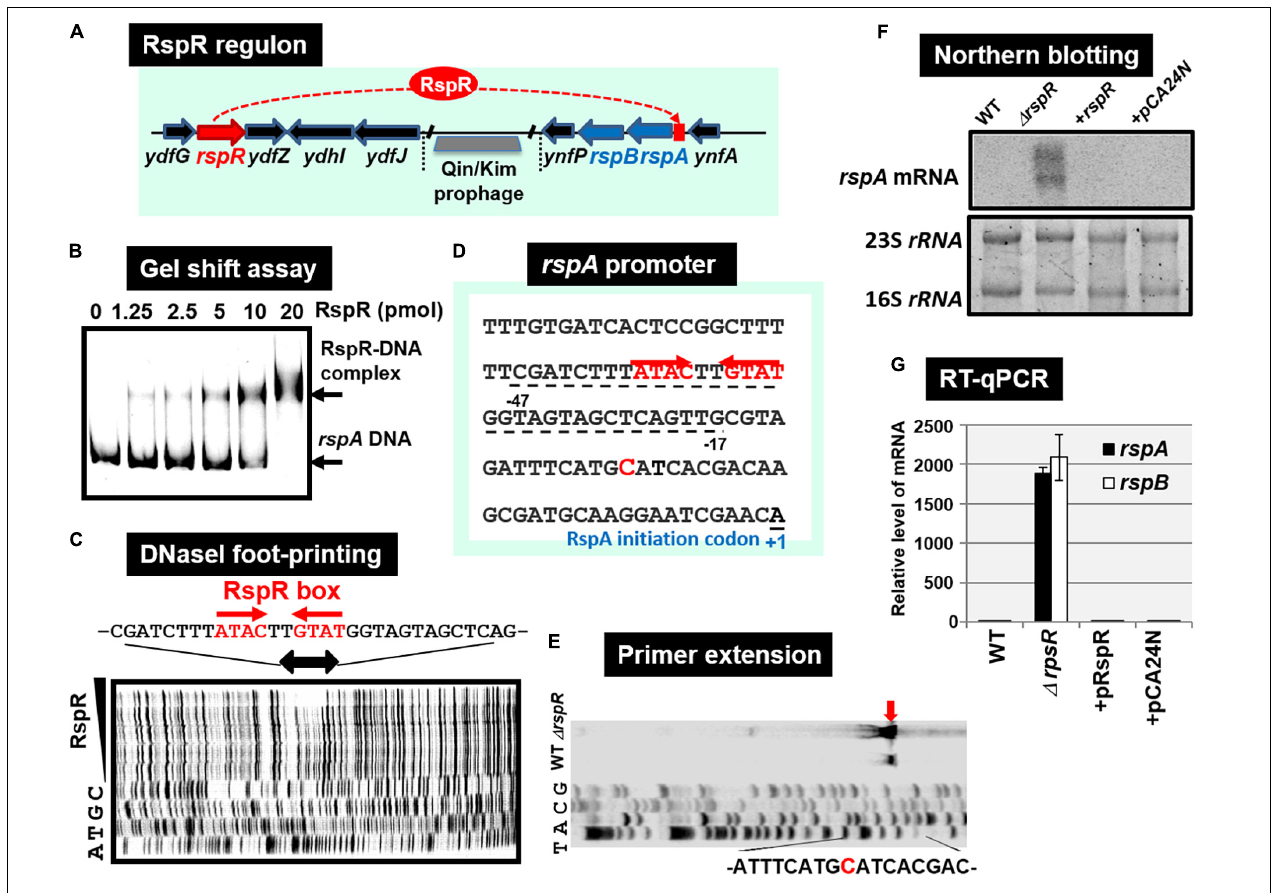
FIGURE 7 | Functional analysis of RspR. (A) Gene organization of the RspR regulon. The rspR gene and its regulatory target rspAB operon are separated by Qin/kim prophage. (B) Gel shift assay of RspR. (C) DNase-I footprinting of the RspR-binding sequence around the rspA promoter region. RspR box is indicated by red arrows. (D) The rspA promoter sequence is shown with the rspA transcription start site (indicated by blue T) and the translation initiation site (indicated as + 1). The sequence protected by RspR is shown with dotted line below the rspA promoter sequence. (E) Mapping the rspA promoter via primer extension. The transcription start site is indicated by blue arrow, and the start nucleotide A on the rspA mRNA is shown in red. (F) Northern blot analysis of rspAB transcript. (G) RT-qPCR analysis of rspAB transcript. In both F and G experiments, RNA was isolated from wild-type, the rspA mutant, the mutant with RspR over-expressing plasmid pRspR, and the mutant with empty vector